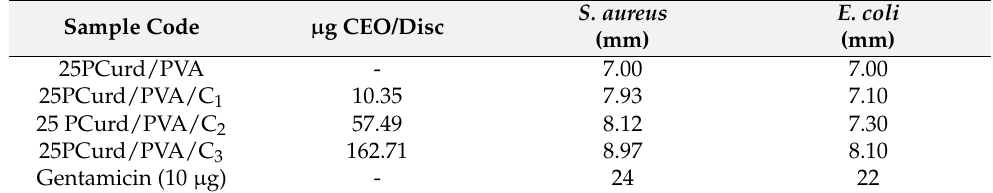
Table 3. The average diameter of zone of inhibition bacterial growth (samples diameter 7